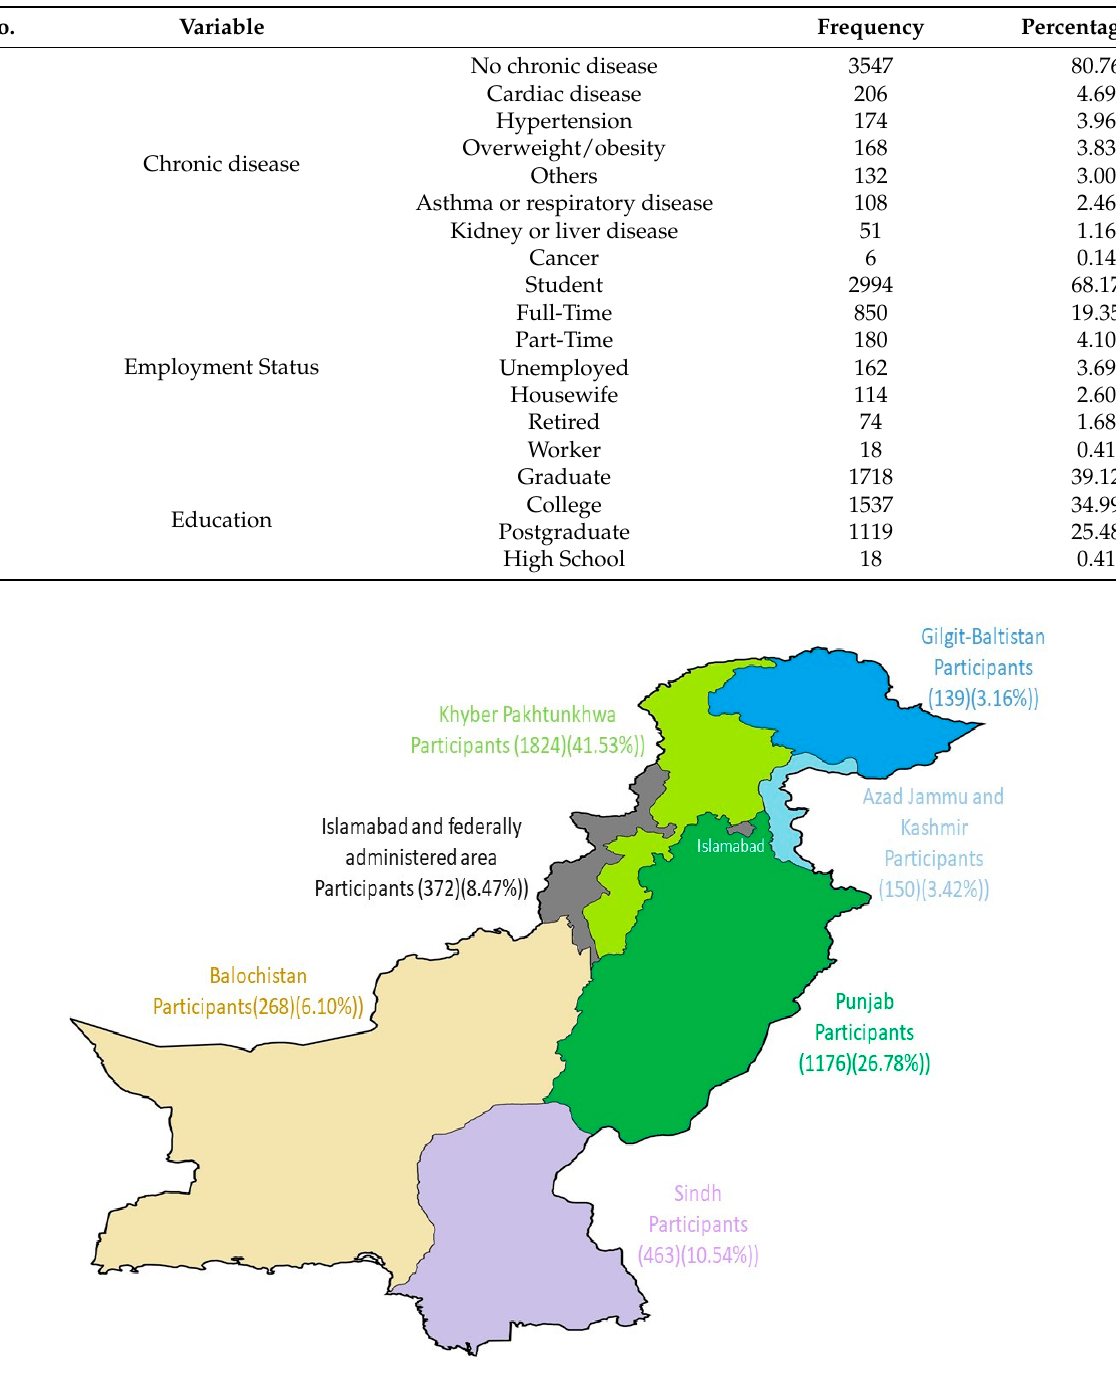
Figure 1. Distribution of participants according to the area. Table 1. Demographic characteristics of the study population ( n = 4392). Approximately 3102 participants (70.62%) had never taken the flu vaccination. At the same time, 37.4% of respondents had a family member who had COVID-19. Most research participants believed that the Ministry of Health provided sufficient information on COVID- 19 vaccines. Concerning intent to get the COVID19 vaccination, 18.69% were hesitant, 4.92% were unwilling, and just 76.39% were willing to do so. About 36.66% and 35.84% of survey participants preferred the Sinopharm, Sinovac and Pfizer vaccines,